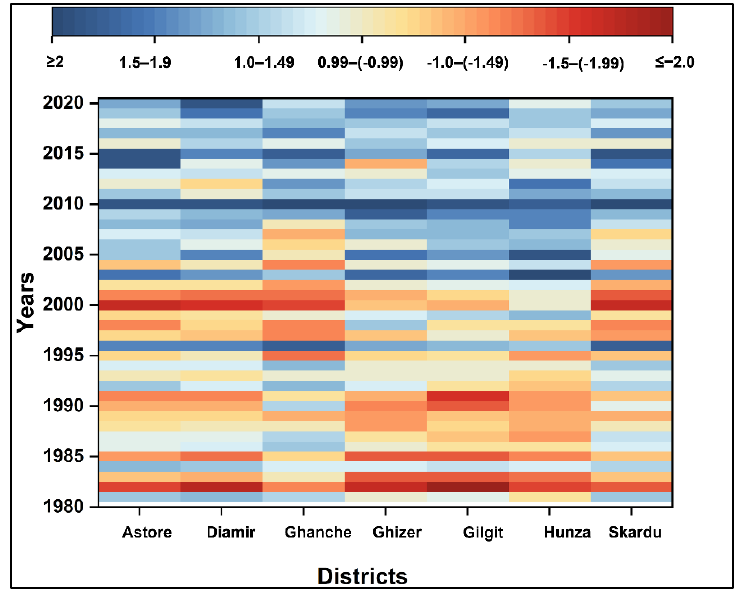
Figure 2. Heatmap of 12 – month SPI series in Gilgit-Baltistan for all districts.